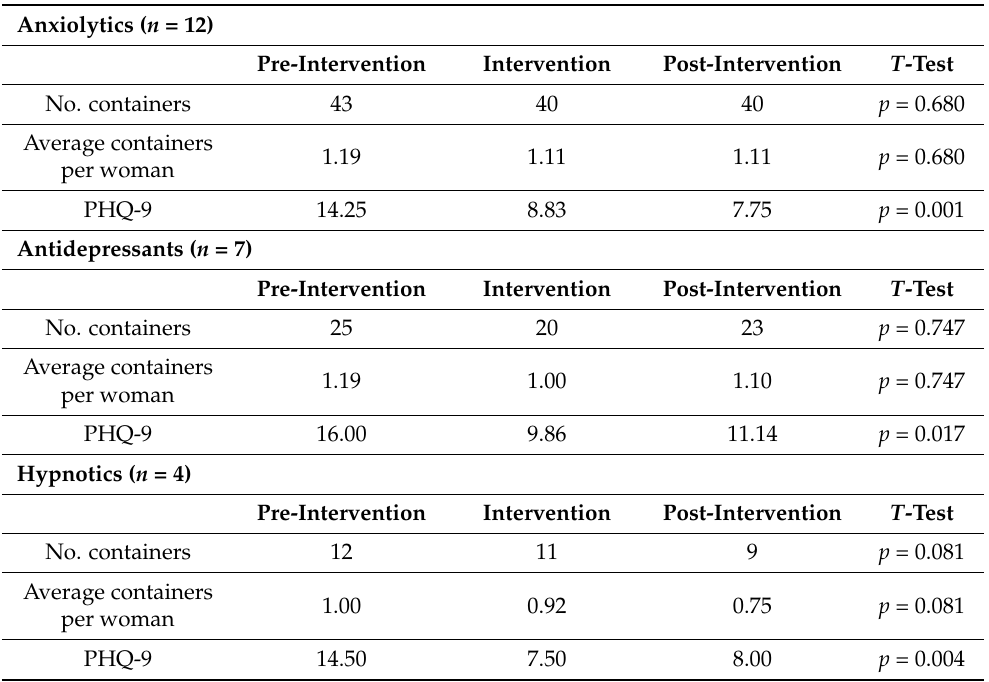
Table 4. Medicines with an official prescription from the health service dispensed between